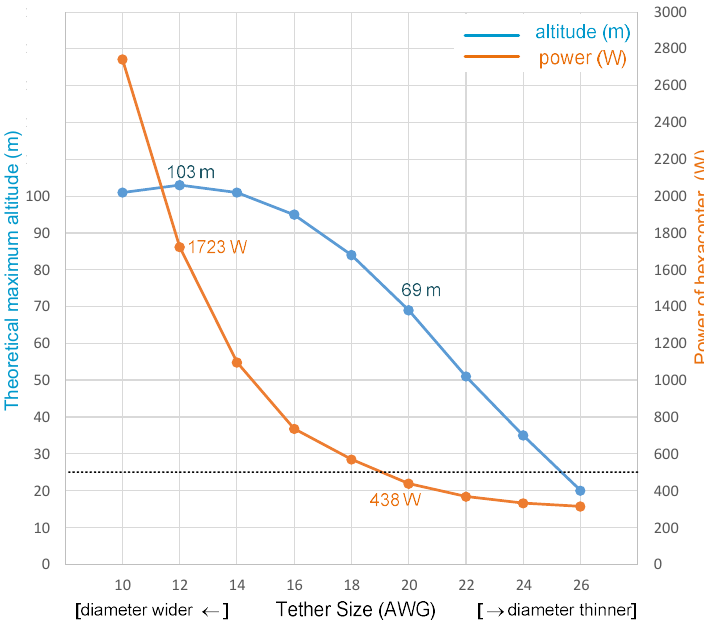
Figure 4. The solid lines indicate the needed power, P n , versus the tether’s length. The dash lines indicate the received power, P r , versus the tether’s length. For a certain tether size, the junction of the solid line and the dash line indicates the maximum altitude and its corresponding power.